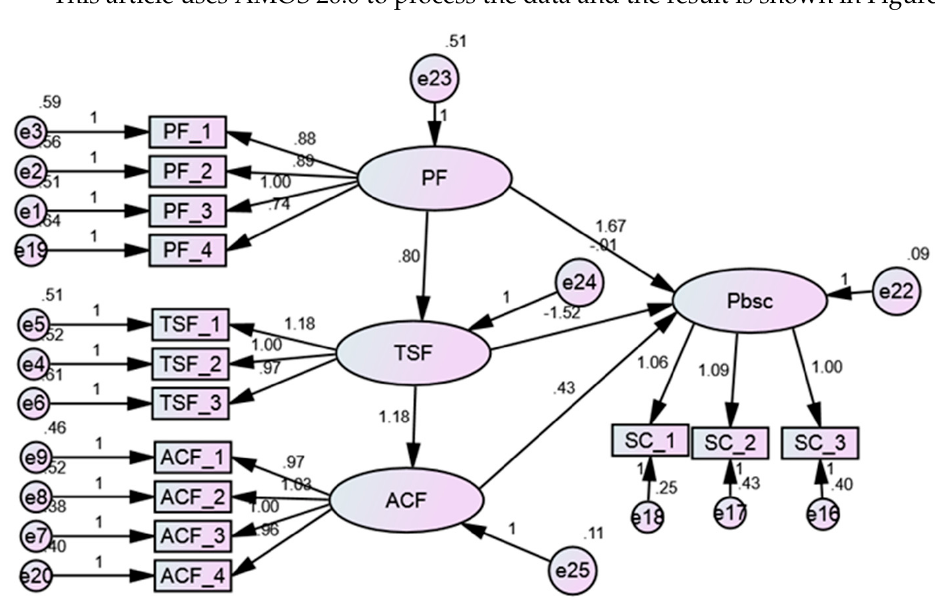
Figure 2. Initial model of PBSC resilience.